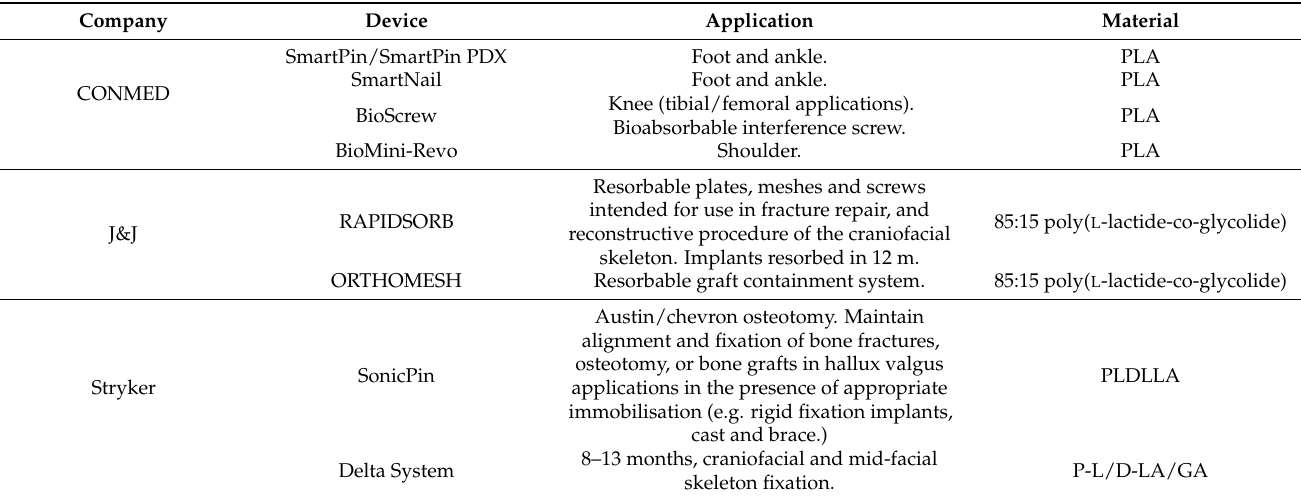
Table 3. Orthopaedic fracture fixation devices on the